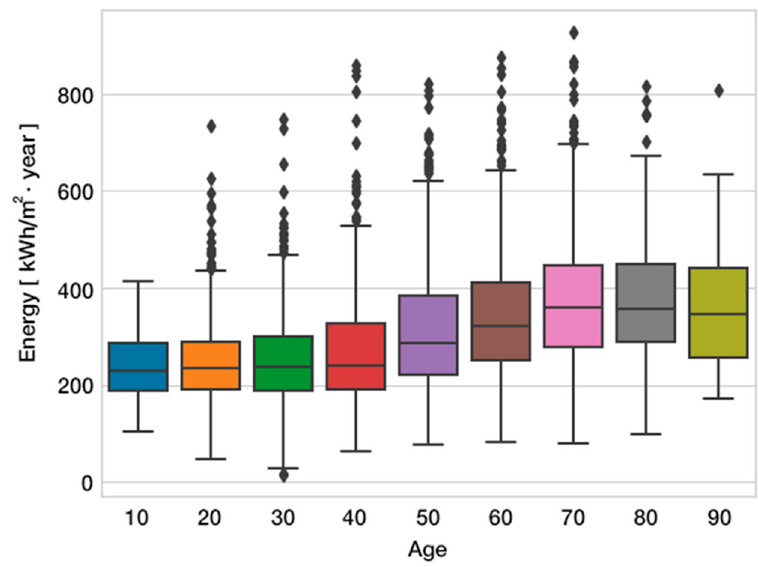
Figure 9. Comparison of energy consumption by age